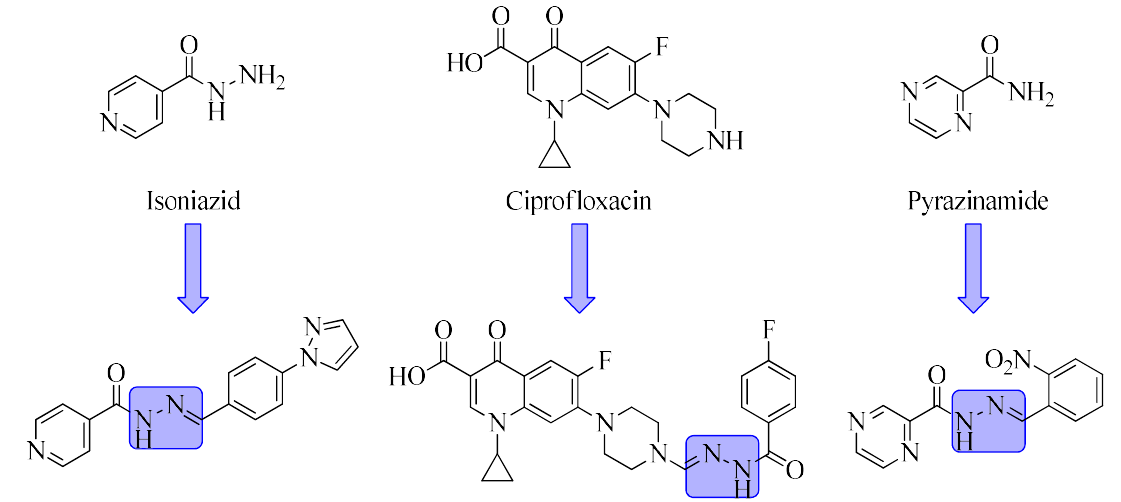
Figure 2. Biologically active hydrazone derivatives of marketed anti-TB drugs.